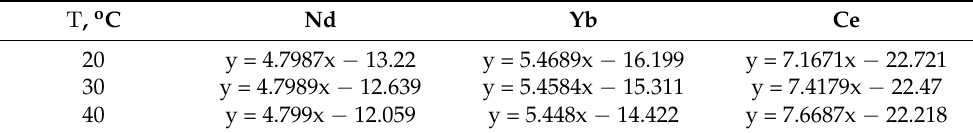
Table 8. Linear approximation of leaching data.